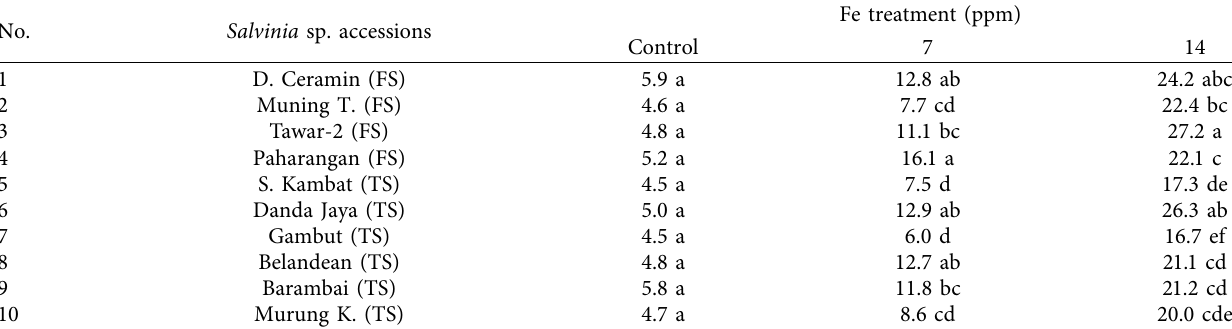
Table 3: The doubling time of Salvinia sp. (days) after 4 weeks of maintenance in some Fe treatments in Hoagland nutrient solution. No. Salvinia sp.